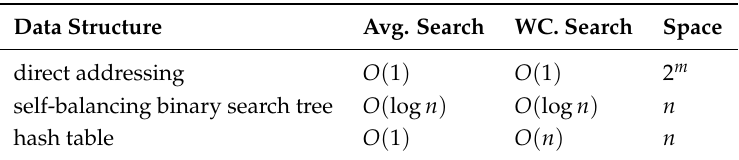
Table 2. Average and Worst Case search complexity, and memory requirements for n elements with m bit